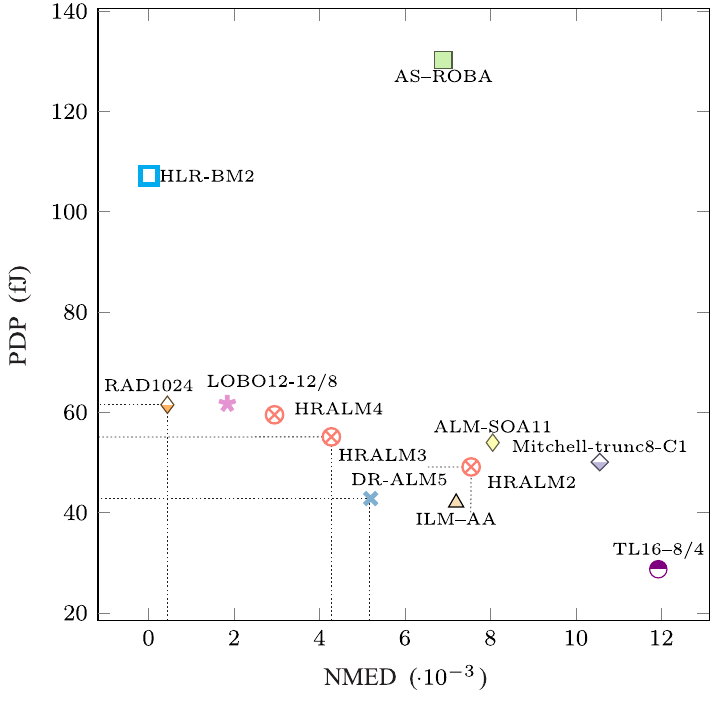
Figure 6. PDP vs. NMED for 16-bit